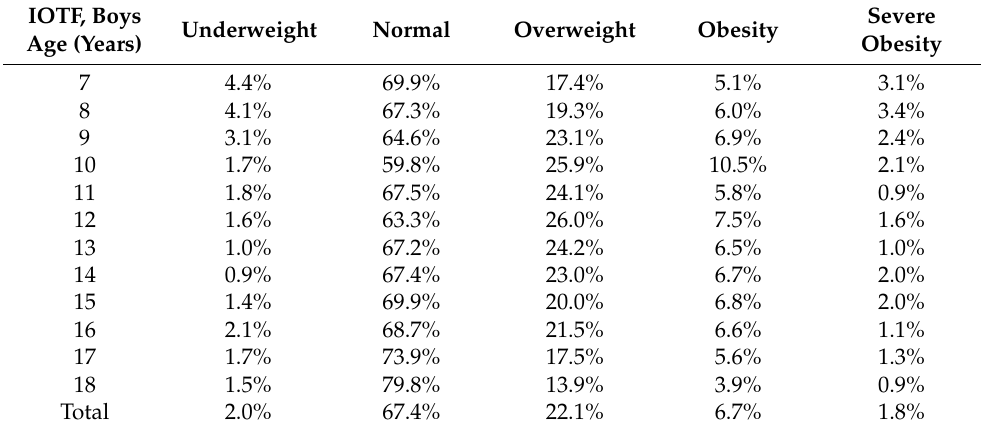
Table 9. Underweight, overweight and obesity prevalence in boys, according to the age, using IOTF cut-offs.